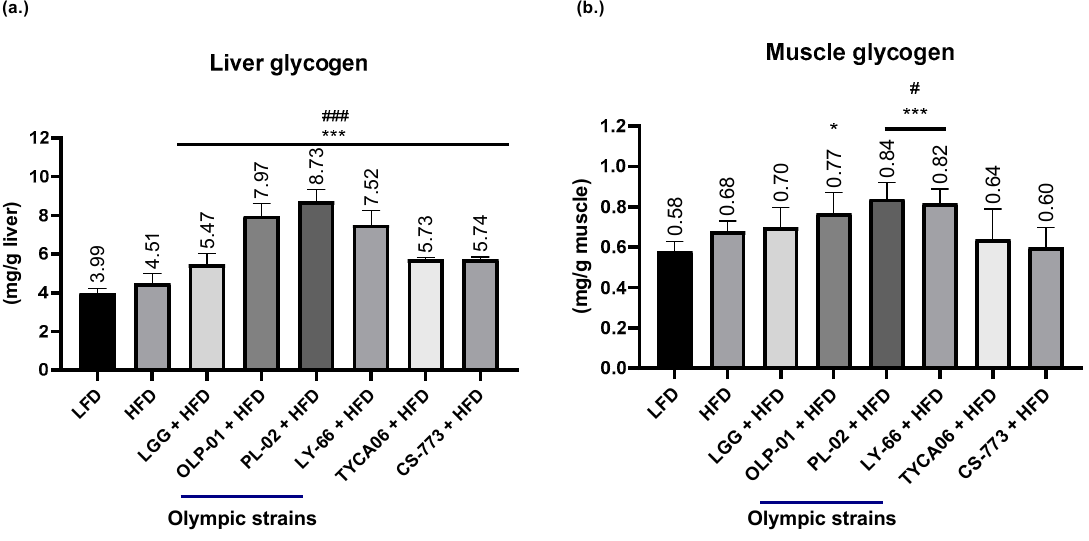
Figure 4. Effects of probiotic treatment on ( a ) liver glycogen levels and ( b ) muscle glycogen levels. OLP-01, PL-02, and LY-66 were isolated from the same Olympic gold medalist. # p < 0.05 and ### p < 0.001 compared with the high-fat diet control group. * p < 0.05 and *** p < 0.001 compared with the low-fat diet group. Data are expressed as the mean ± SD for n = 8 mice per group.